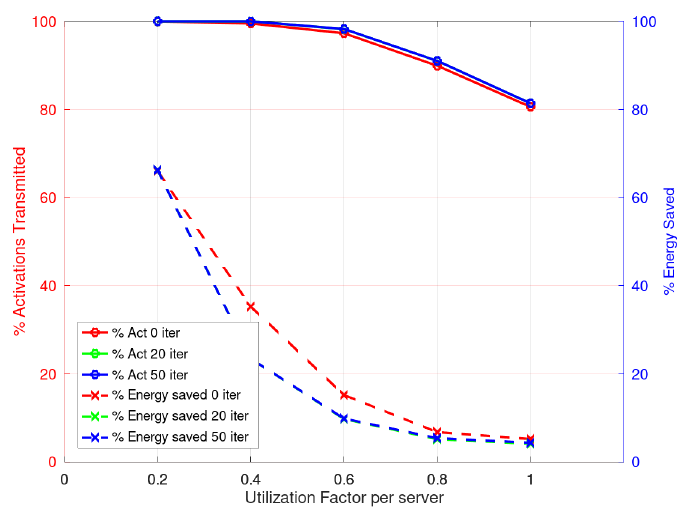
Figure 7. Simple heuristic, activation